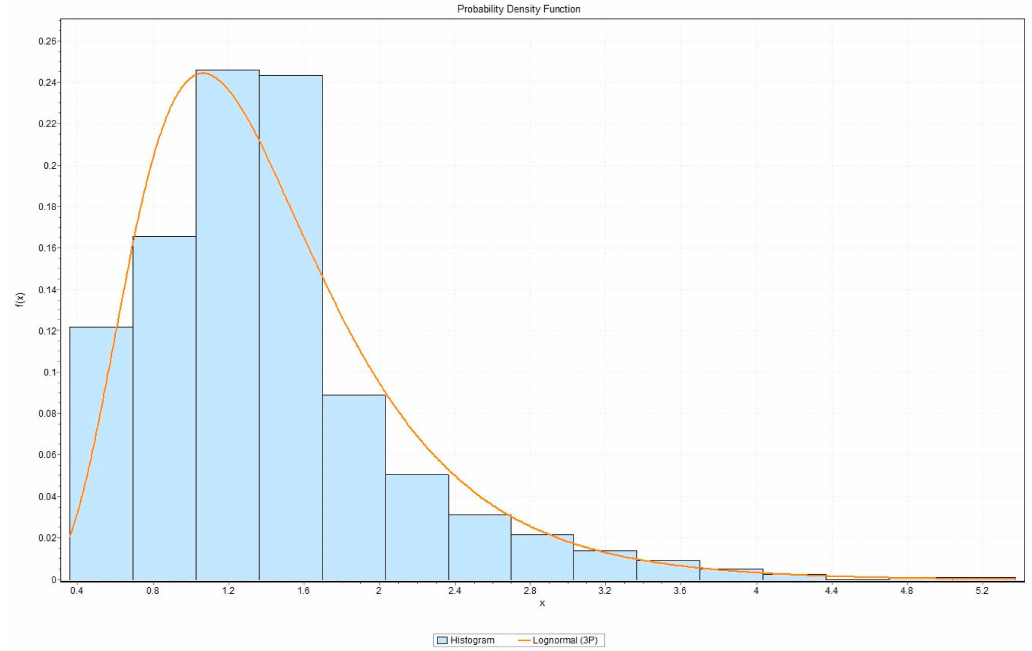
Figure 5. Probability density function for the 3-P lognormal distribution during the event of